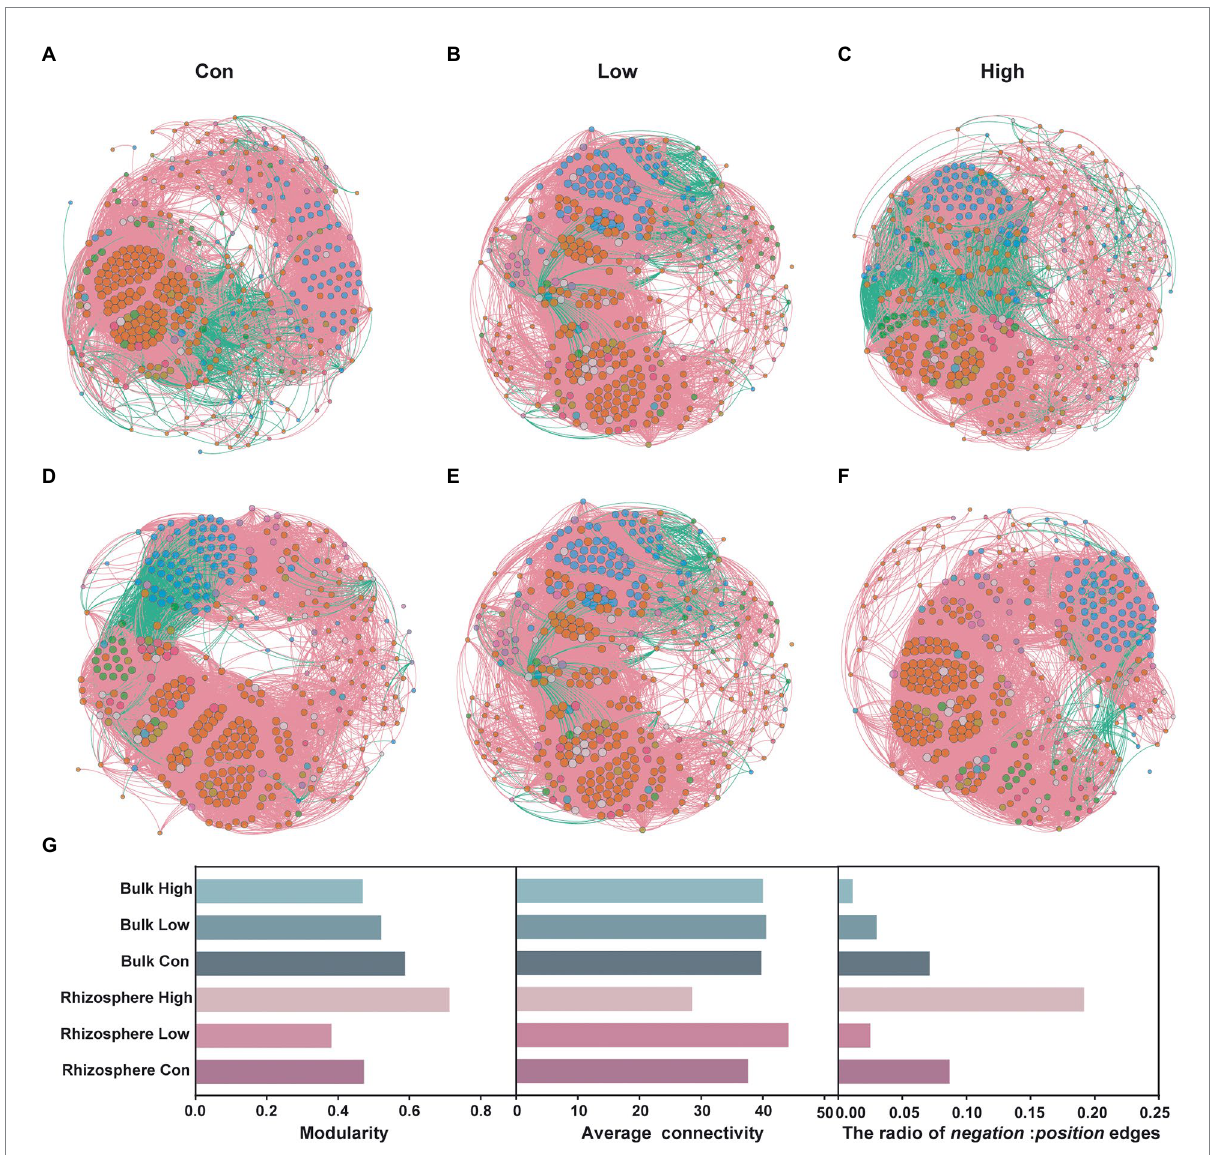
FIGURE 2 Effects of abamectin on the stability of bulk and rhizosphere microbial communities. (A–C) Co-occurrence patterns of genera in the control, low and high of abamectin treatments in rhizosphere. (D–F) Co-occurrence patterns of genera in the control, low and high of abamectin treatments in bulk. Nodes are colored according to the main phyla, and node size represents the number of connections. (G) Modularity, average connectivity, and the ratio of negative : positive edges of co-occurrence